Question: Which kind of chart has been used to present this data?
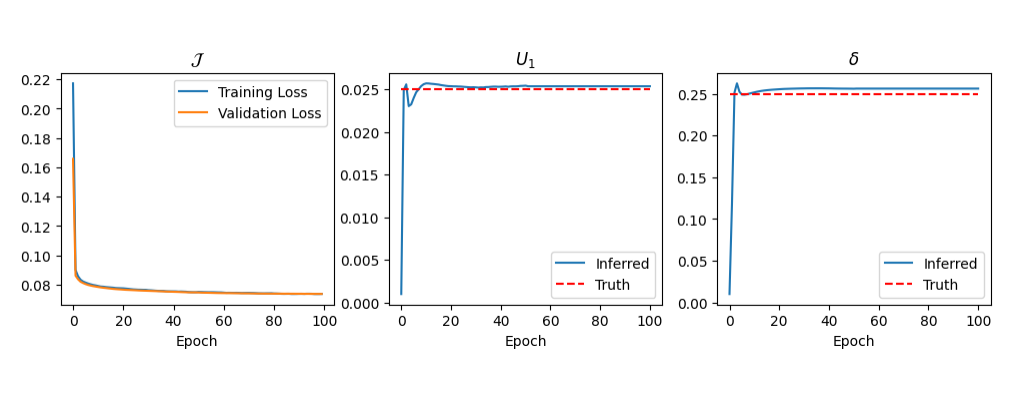
Answer: line